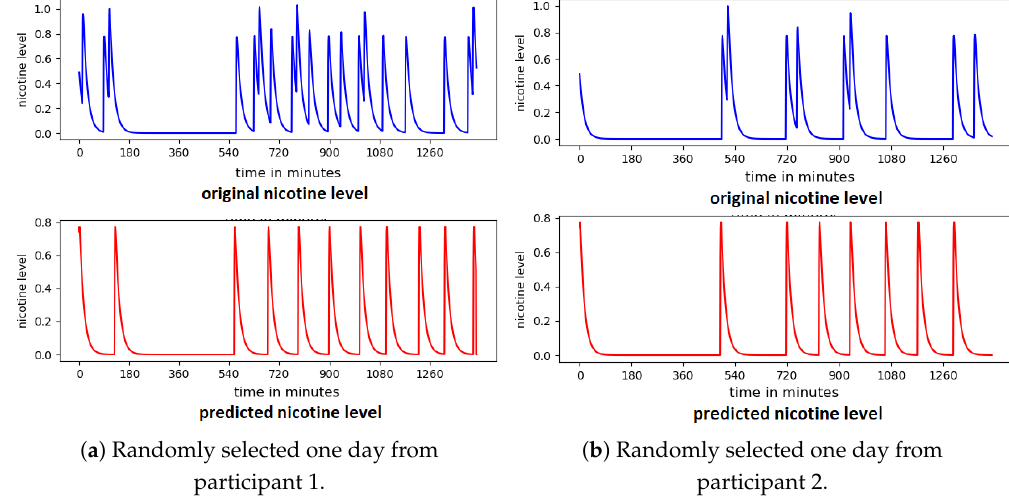
Figure 12. Predicted nicotine level from two